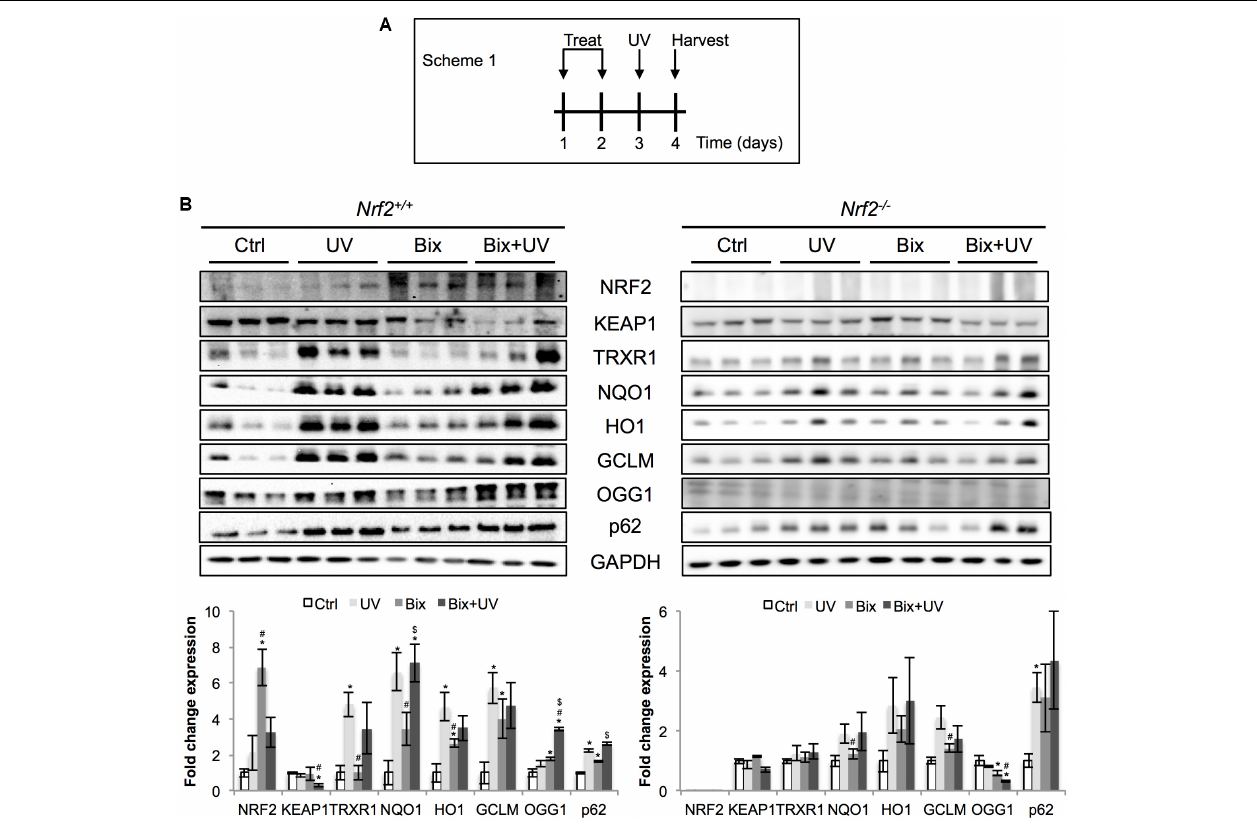
FIGURE 2 | Topical bixin and UV modulate the expression of NRF2 pathway proteins in SKH1 mouse skin. (A) Treatment scheme of acute photodamage study. SKH1 Nrf2 + / + and Nrf2 − / − mice were treated with vehicle control (Ctrl) or 1% bixin (Bix), alone or in combination with solar UV (UVB 240 mJ/cm 2 ) (UV, Bix + UV). Skin tissues were collected for analysis 1 day after exposures. (B) Protein expression of NRF2 and its downstream genes in skin tissue lysates as assessed by immunoblot analyses. Protein expression was quantified, normalized, and represented as fold change compared to controls. Blots of three representative samples for each group are shown. p < 0.05: ∗ compared to Ctrl, # compared to UV, $ compared to